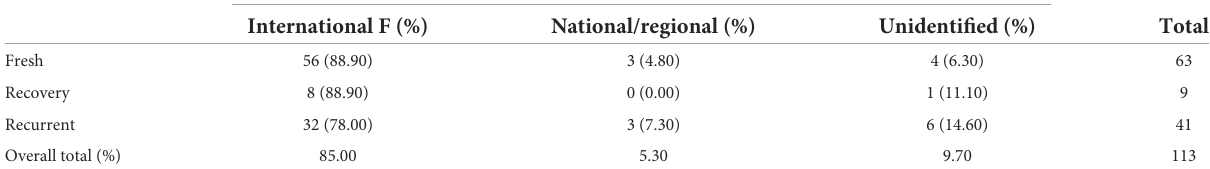
TABLE 2 The prevalence of injury status across